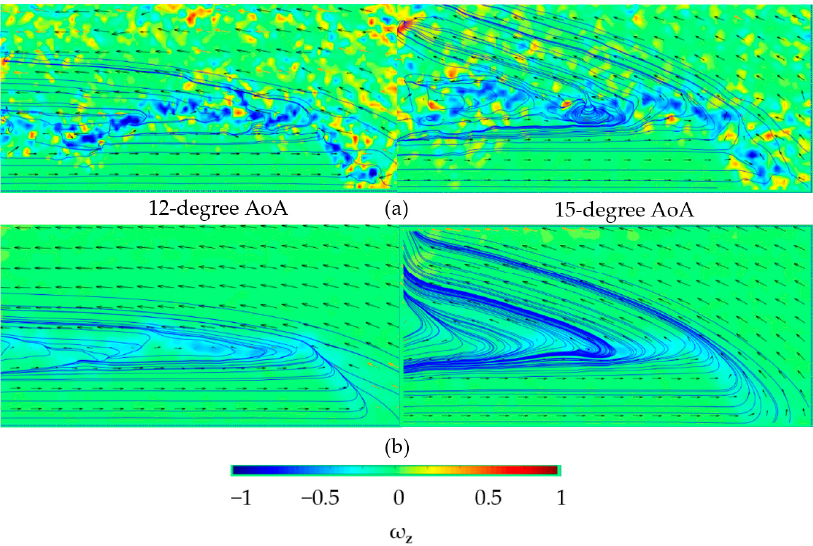
Figure 11. Instantaneous ( a ) and average ( b ) spanwise vorticity ( ω z ) fields superimposed with average vector field at center plane ( z = 0 mm) for 12-degree AoA (left) and 15-degree AoA (right). Vector fields and streamlines are the result from applying a convective velocity subtraction.